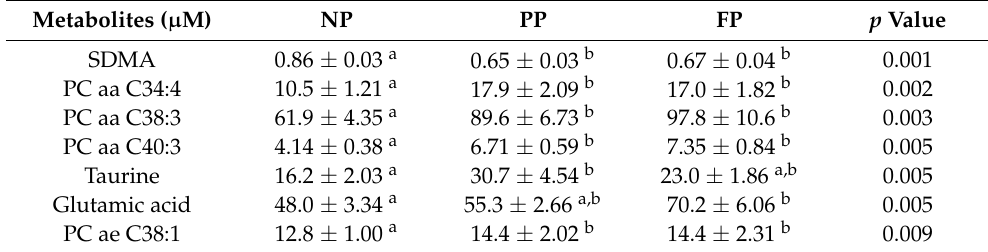
Table 2. Mean concentration of significant metabolites ± standard error of the mean for cows in pre-delivery period (after receiving the prenatal nutritional treatments) with their respective p